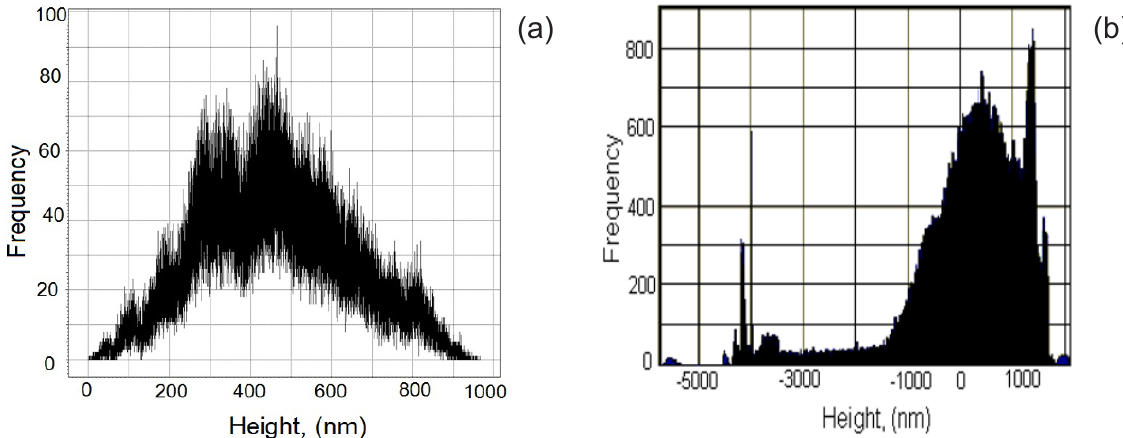
Figure 8. The histogram of the surface roughness of thallium sulfide film. PE initially treated with a solution of H immersed in